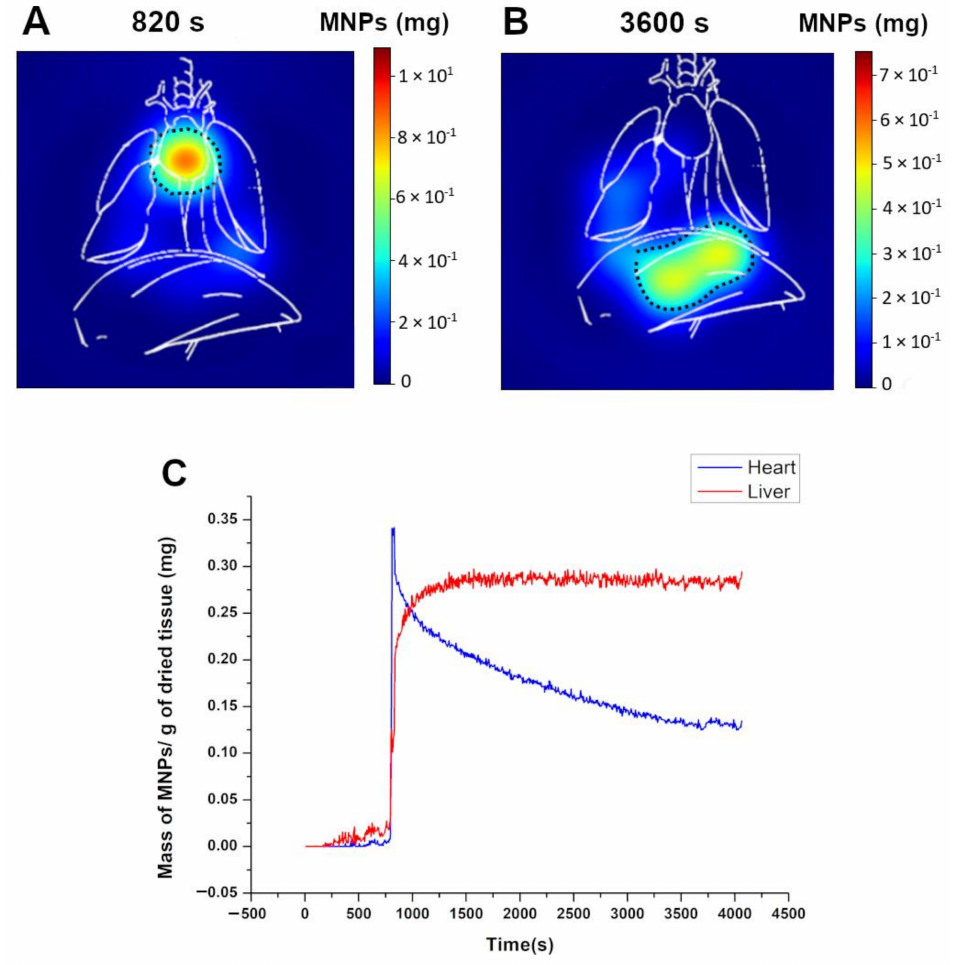
Figure 4. Representation of the biodistribution by frames after injection and the specific ROIs selected to access the pharmacokinetic parameters; ( A ) 820 s, showing the high and low concentrations of MNPs in the heart and the liver, respectively; ( B ) 3600 s, indicating the final biodistribution process, which was characterized by a solely higher intensity signal in the liver; and ( C ) the average intensity over time for ROI 1 (heart region) and ROI 2